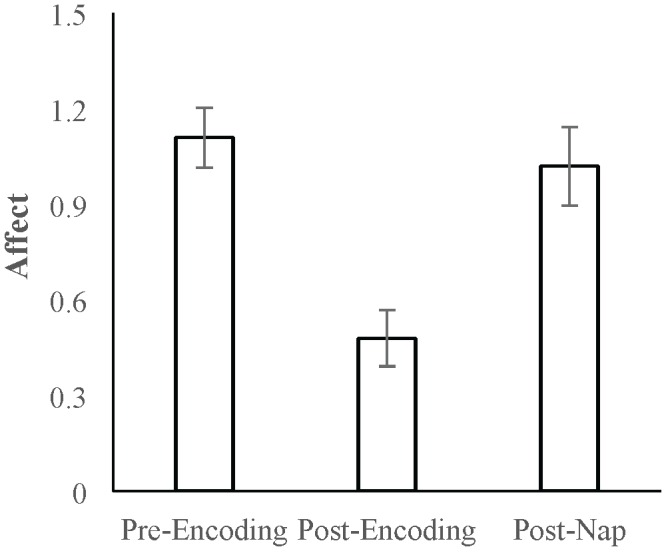
Mean Affect Ratio (adjusted ratio of positive to negative affect) at the pre-Encoding, post-Encoding, and post-nap time-points. Error bars represent standard errors of means.